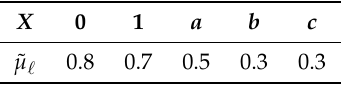
Table 7. The length of ( X , ˜ µ )